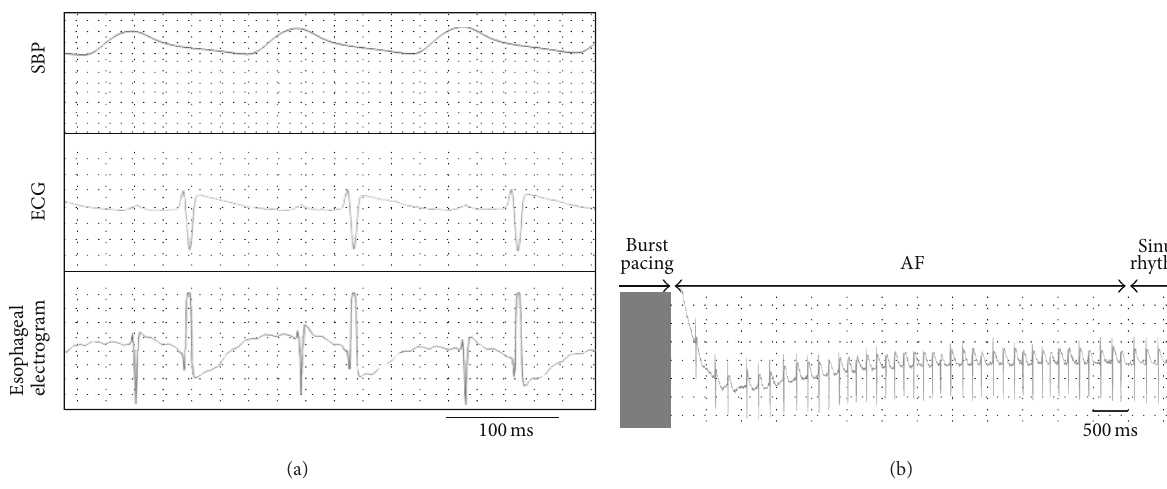
Figure 1: (a) A typical tracing of systolic blood pressure (SBP), ECG, and esophageal electrogram. (b) A typical time course of induced atrial fibrillation (AF) followed by burst pacing. ECG shows induced AF after burst pacing and spontaneous termination of AF.